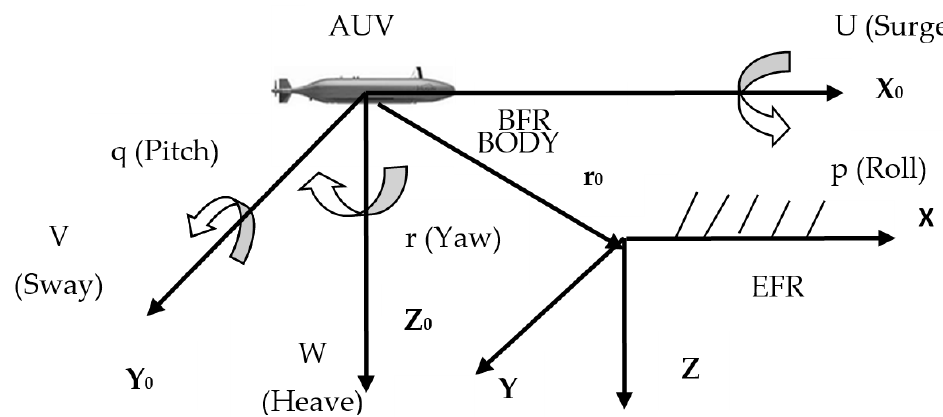
Figure 1. AUV dynamics in BFR and EFR [33].